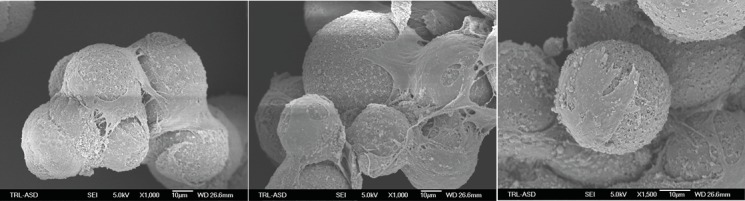
Scanning electron microscope micrographs of the recombinant human collagen-based microspheres loaded with porcine ASC.Original magnification is indicated underneath the image. Abbreviation: ASC: adipose tissue-derived stromal cells.